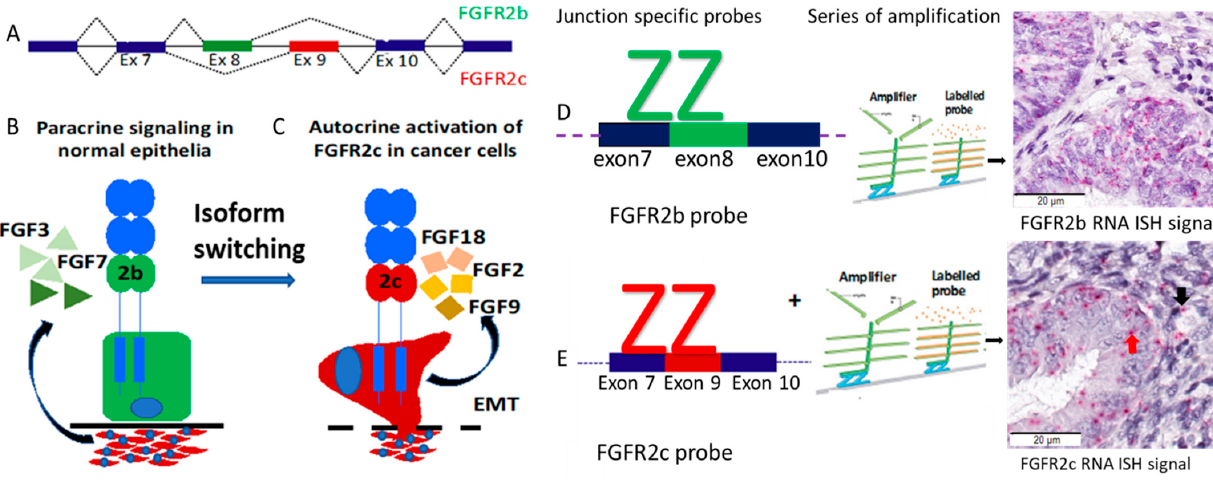
Figure 1. FGFR2 isoform switching, paracrine and autocrine signalling, and RNA ISH probes design. ( A ) Mechanism of alternative splicing. FGFR2 has two alternative spliced isoforms, FGFR2b and FGFR2c and these differ only in the second half of the third immunoglobulin-like loop (Ig-III) in the extracellular domain. Inclusion of exon 8 and exclusion of exon 9 gives rise to the FGFR2b “2b” isoform and inclusion of exon 9 and exclusion of exon 8 gives rise to the FGFR2c “2c” isoform. ( B ) The FGFR2b isoform is normally expressed in epithelial cells and stimulated by FGF ligands (for example, FGF3, FGF7) expressed by underlying stromal cells. ( C ) Carcinoma cells undergo isoform switching during progression resulting in autocrine receptor activation. ( D , E ) Principles of probe design and representative micrography of RNA ISH showing ( D ) FGFR2b isoform ( E ) FGFR2c isoform signals. FGF, Fibroblast Growth Factor; FGFR2, Fibroblast Growth Factor Receptor.